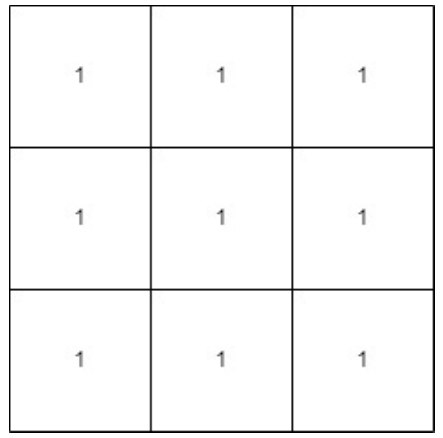
Figure 5. Visualization of 3 × 3 rectangle shape structuring element.